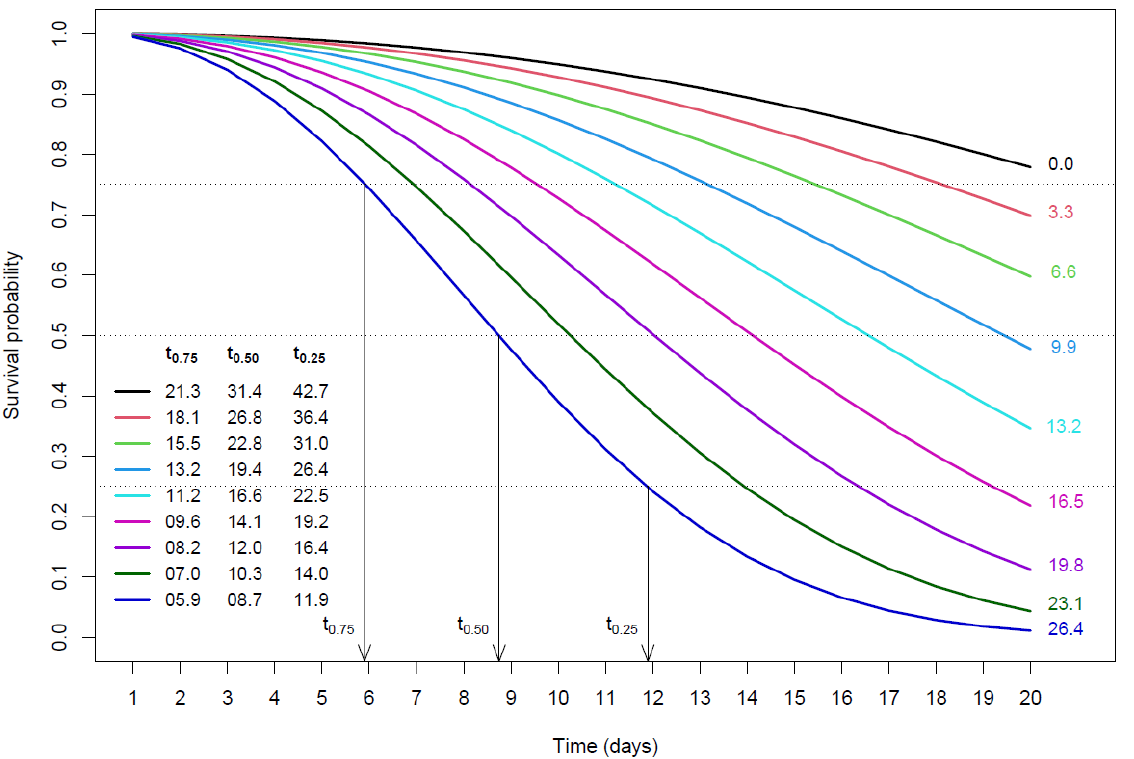
Figure 3. Survival curves estimated by the Weibull model for Chrysoperla externa exposed to different doses (mg a.i. L − 1 ) in Organic neem ® . The times for 75%, 50%, and 25% of the individuals to be alive are also presented.